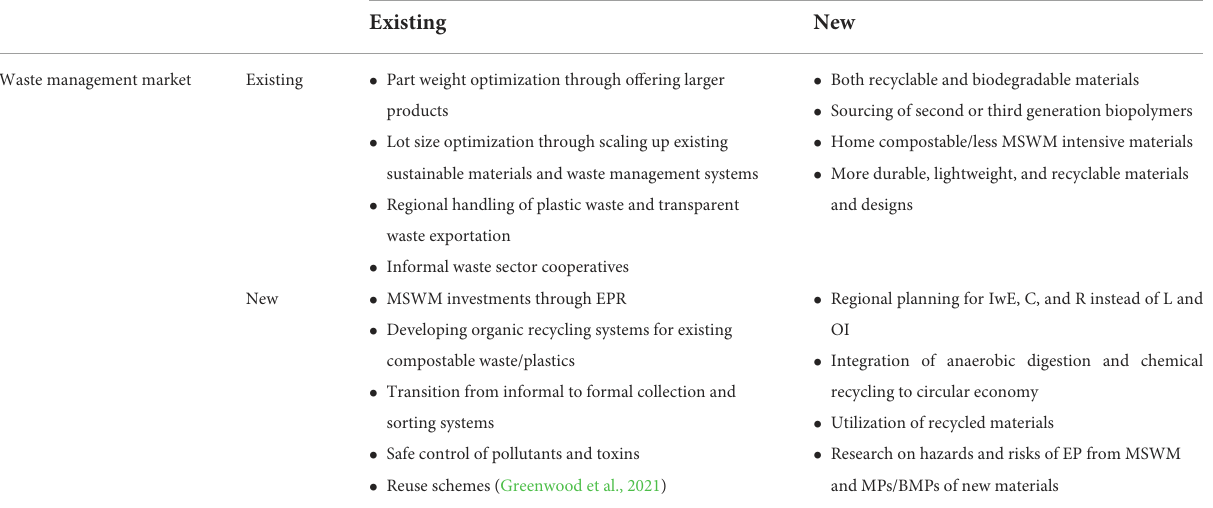
TABLE 8 Plastic sustainability